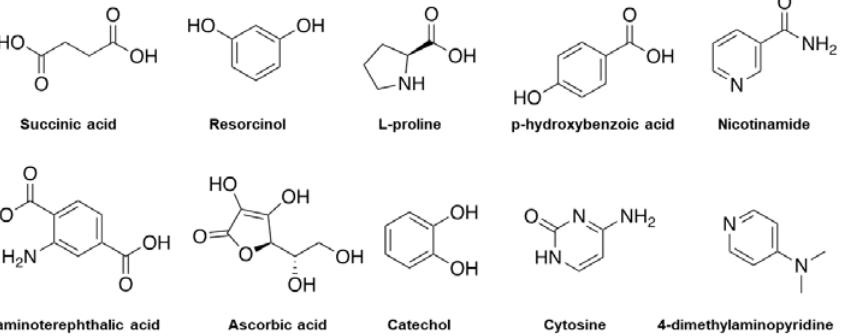
Figure 5. Examples of chemical molecules used for coformer formation. Methods of forming multicomponent crystals can be classified as either thermody- namic or kinetic methods (Figure 6). Kinetic method deals with non-equilibrium condi ‐ tions depending on the energy of the system and the duration of the reaction. These